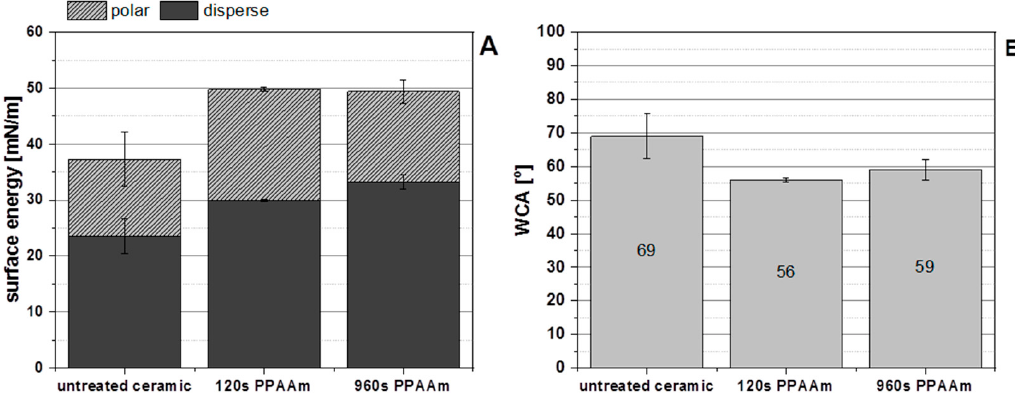
Figure 7. Surface energy ( A ) and water contact angle ( B ) of the untreated and PPAAm-coated smooth ceramic surface ( n = 3). Note the tendency toward enhanced surface energy (dispersed and polar